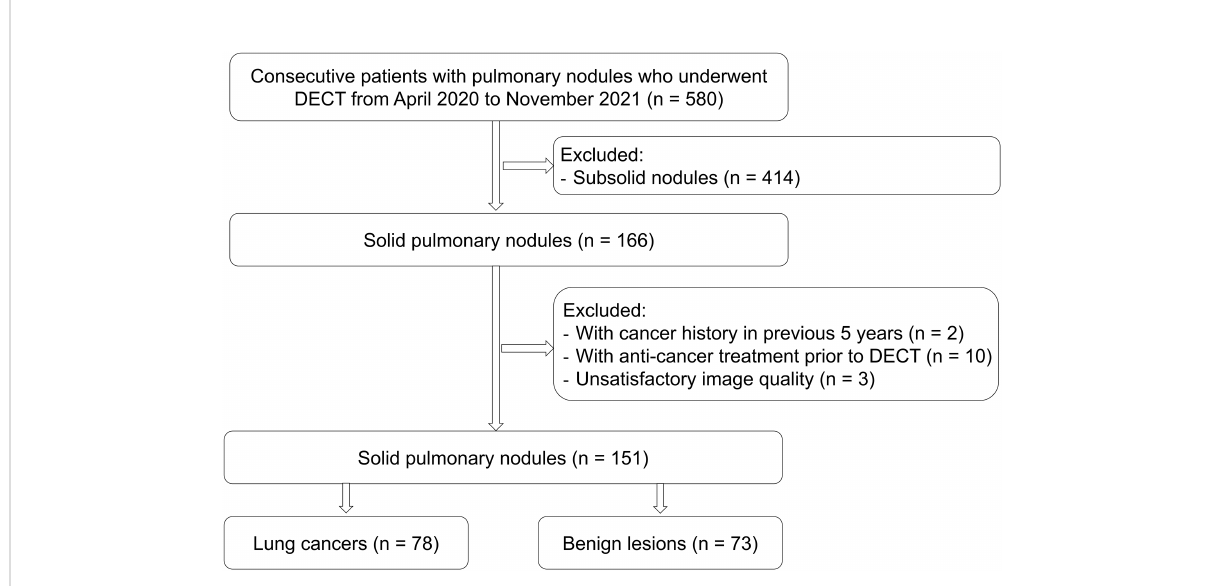
FIGURE 1 The fl owchart for nodule recruitment. DECT, dual-energy computed